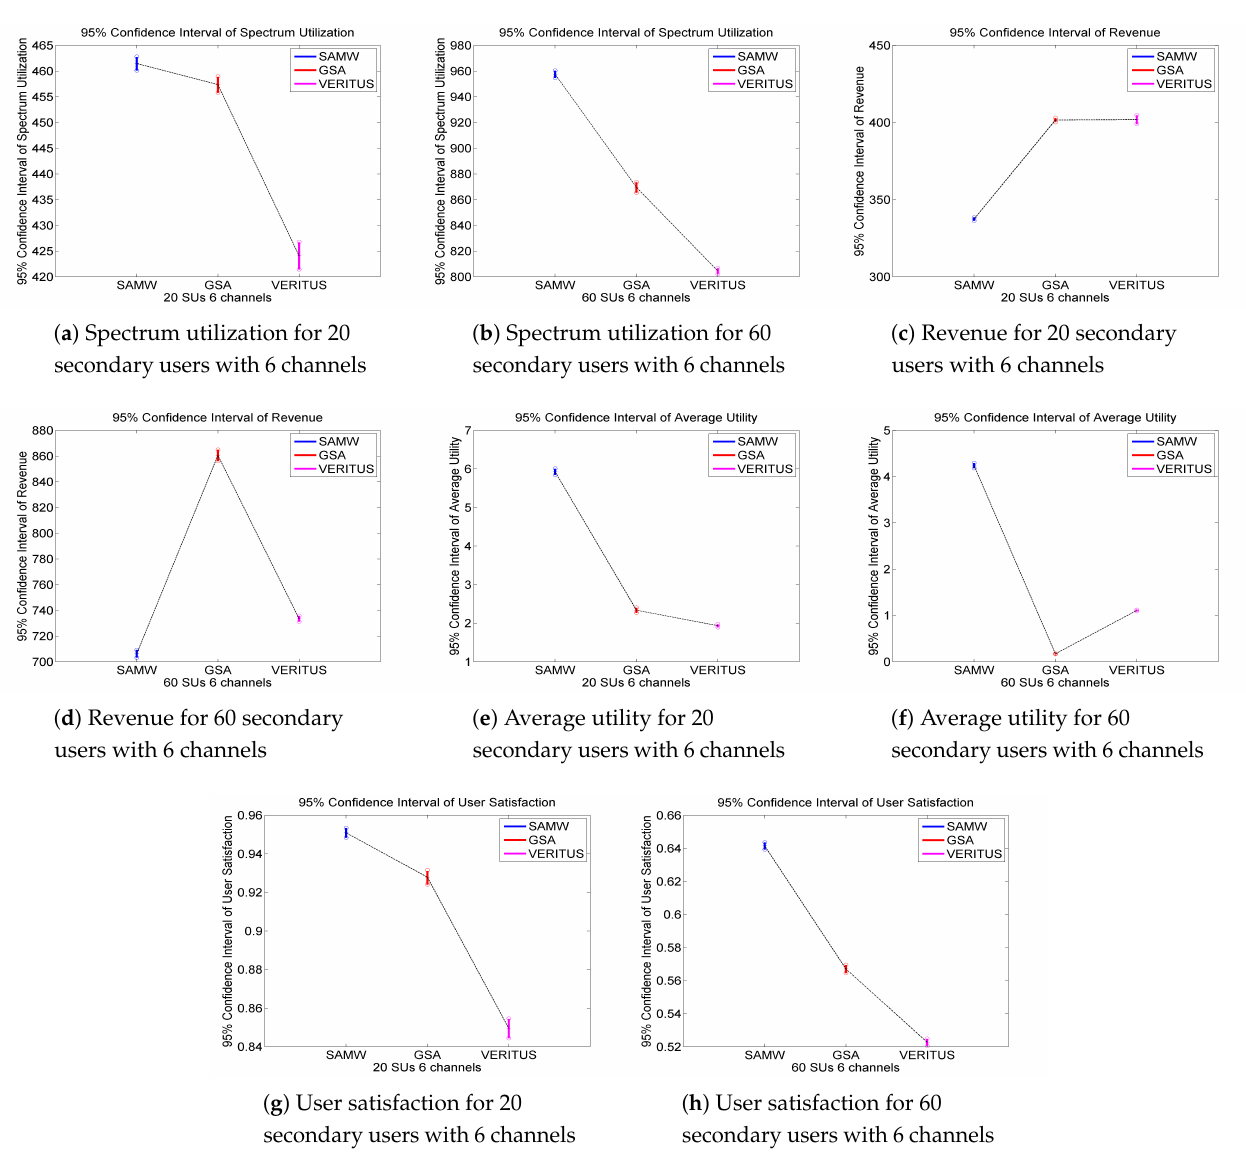
Figure 9. Confidence intervals at 95% confidence level for spectrum utilization, revenue, average utility and user satisfaction for 20 SUs with 6 channels and 60 SUs with 6